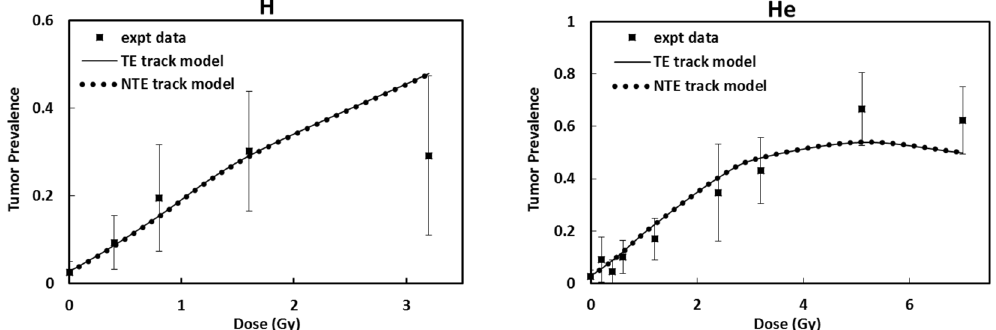
Figure 2. Comparison of targeted effects (TE) and non-targeted effects (NTE) models for proton and helium beams to the experiment of Alpen et al . 12 for the dose response for Harderian gland tumor prevalence. Results show NTE are small for low LET particle beams.